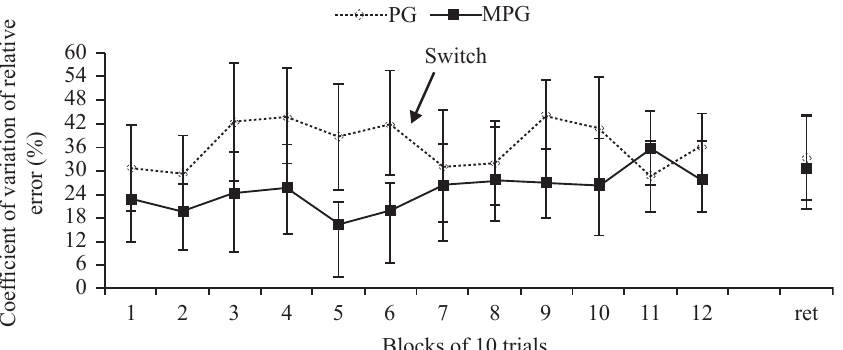
Figure 3. Coefficient of variation of the relative error in the acquisition phase and in the retention test. The vertical bars denote the confidence interval in